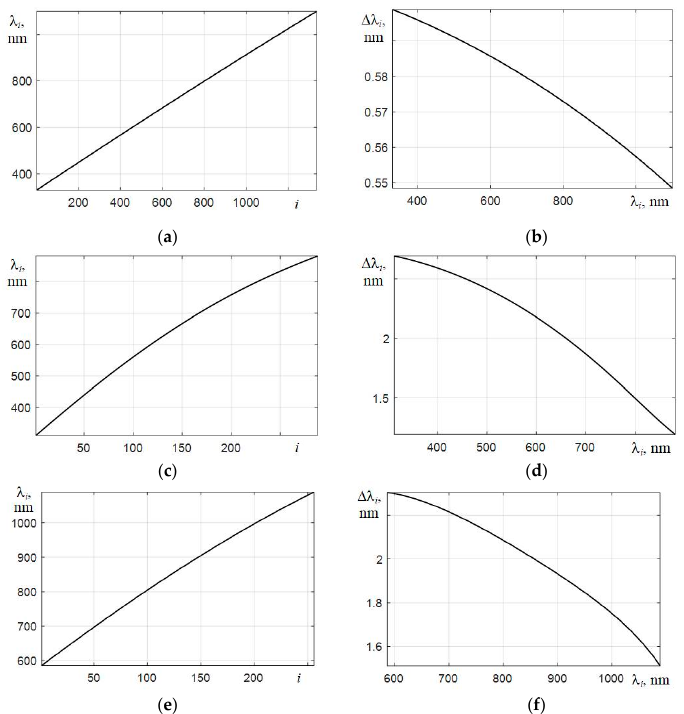
Figure 4. Counts λ i vs. the element number of the array of photodetectors i and the interval Δλ i between the counts for the AvaSpec spectrometer ( a , b ) and microspectrometers C12880MA ( c , d ) and C11708MA ( e , f ), respectively.